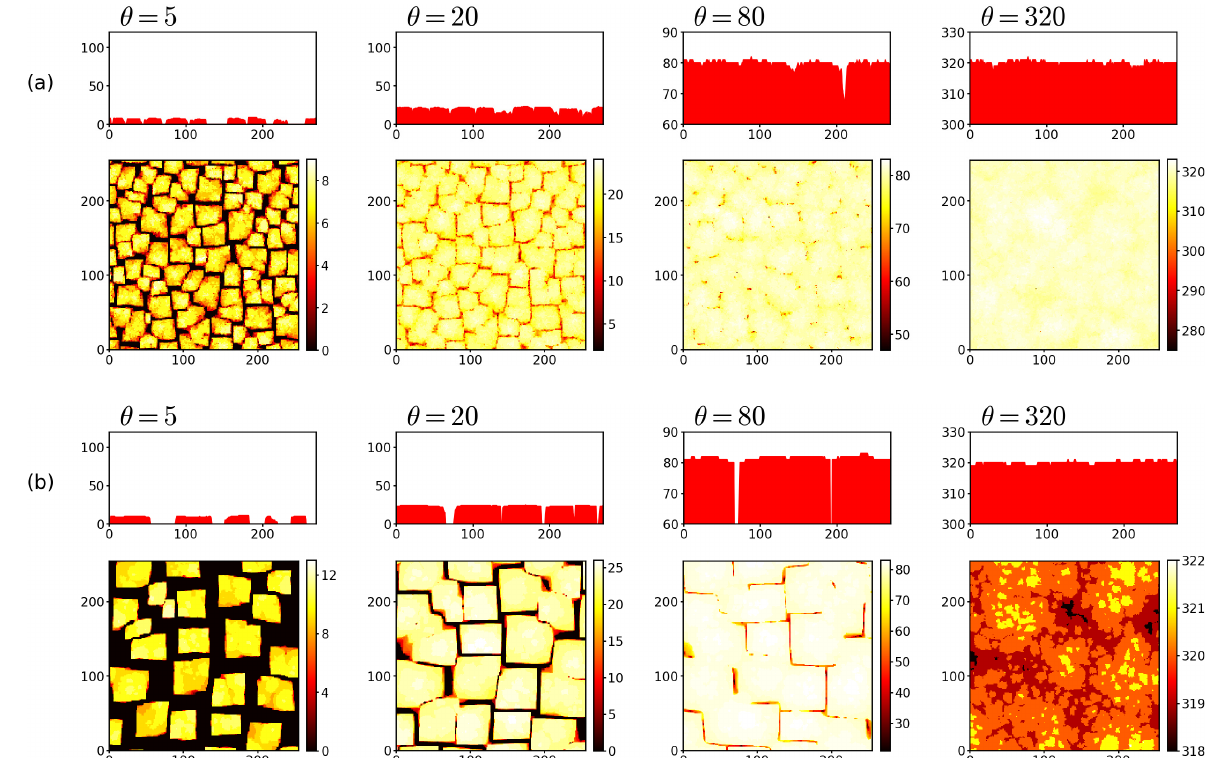
Figure 2. Vertical cross-sections and top views of parts of the deposits grown in simulations with negligible ES barriers. Parameter sets ( a ) A and ( b ) A1. Cross-sections not in scale and some are restricted to the upper layers. All lengths are in units of the lattice